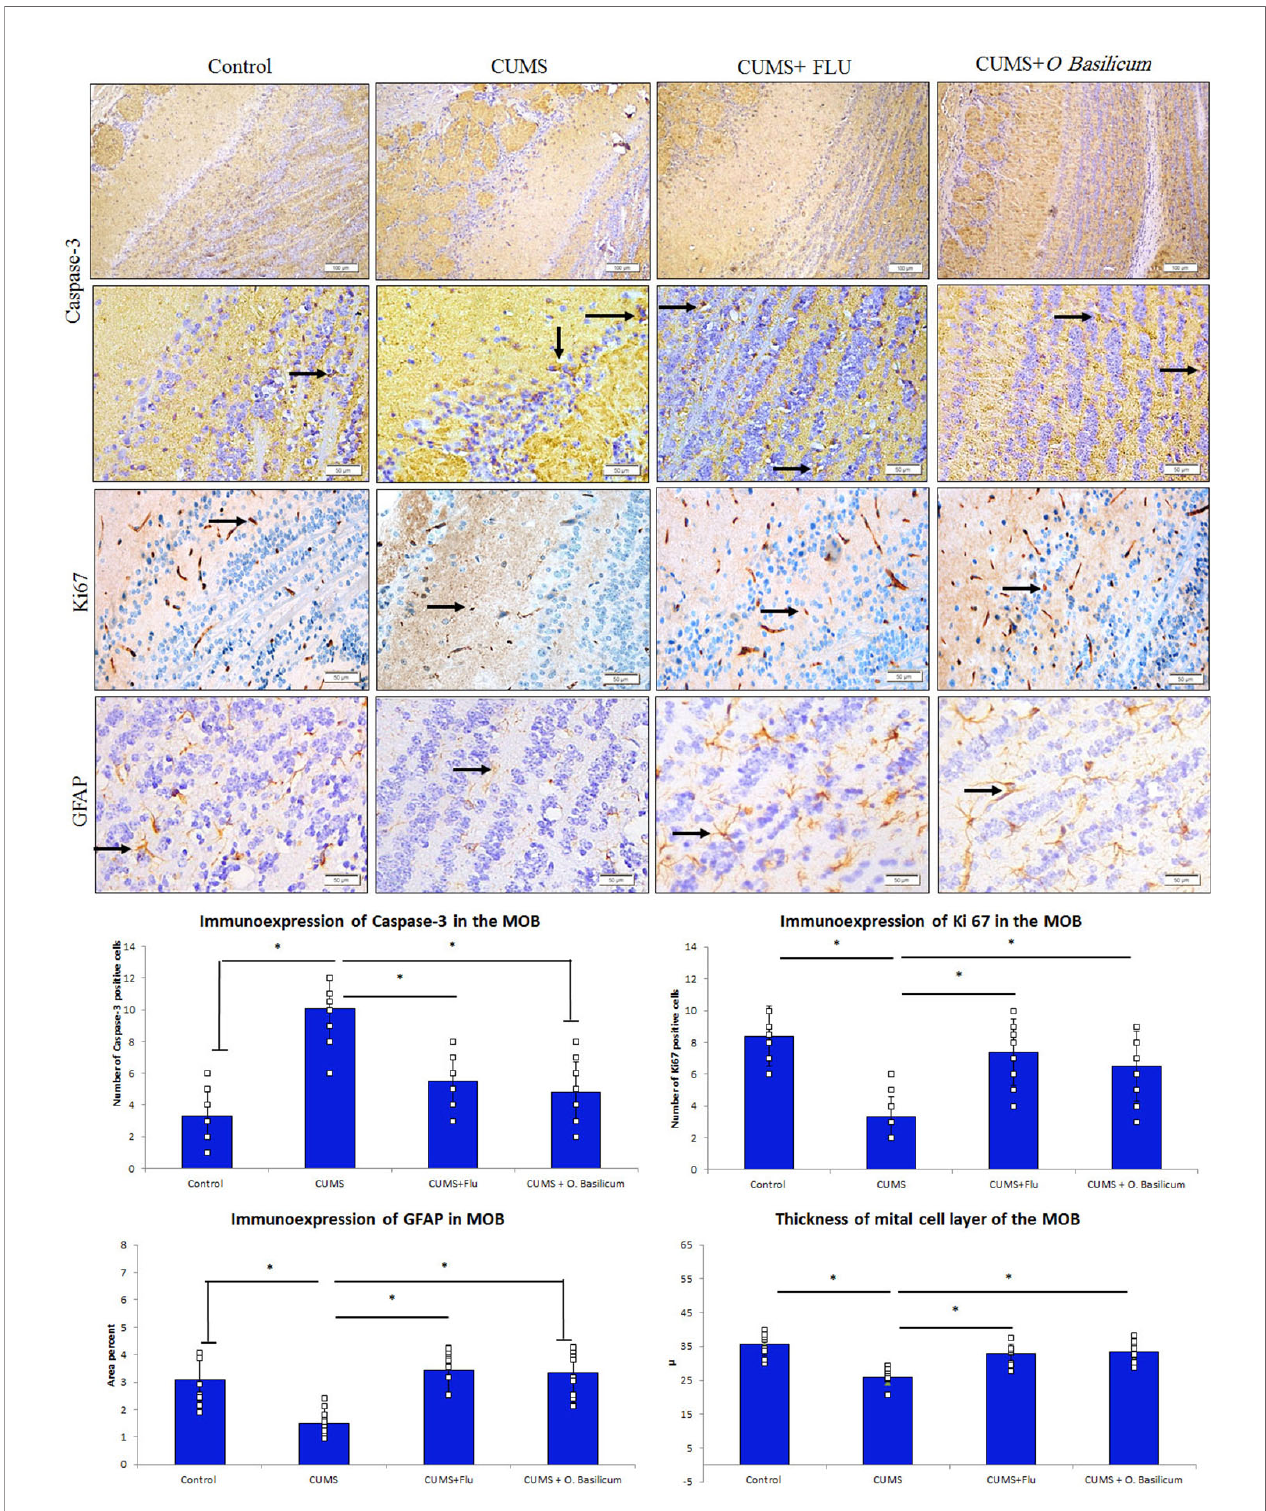
FIGURE 4 | Effect of Ocimum basilicum on the immunoexpression of caspase-3, Ki67, and GFAP in the MOB of the studied groups. Main olfactory bulb (MOB), chronic unpredictable mild stress (CUMS), fl uoxetine (FLU), O. basilicum (Ocimum basilicum). * signi fi cance with p <